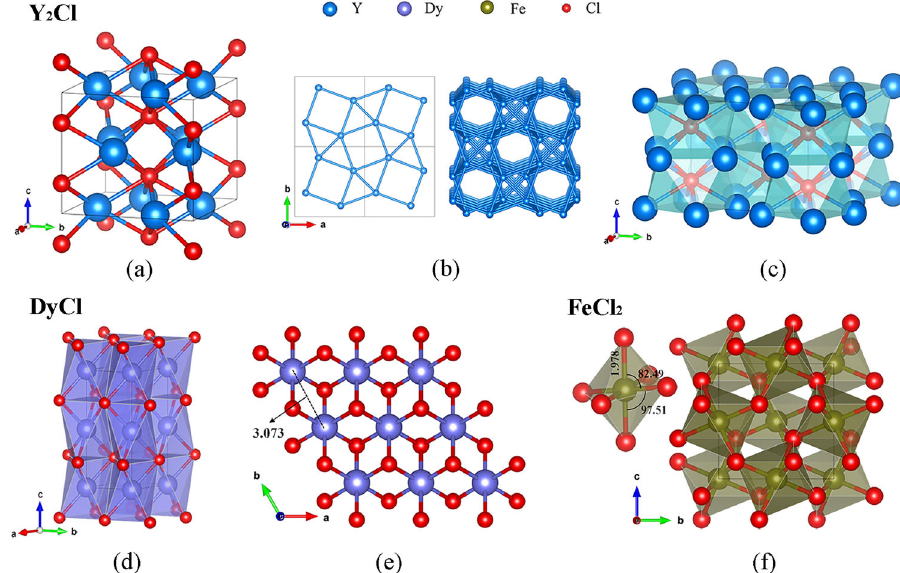
Fig. 2 Crystal structures of novel chlorides of Y, Dy, and Fe. a Stick-and-ball model of Y 2 Cl structure at 41(1) GPa; b view of the Y metal framework in Y 2 Cl along the c -direction; c square antiprisms geometry around the Cl center in Y 2 Cl. d Polyhedral model of the crystal structure of DyCl at 40(1) GPa built of YCl 6 octahedra; e view of the structure along the c -direction: Cl atoms form hexagonal close packing ( hcp ) and Y atoms occupy the space in between. f Polyhedral model of FeCl 2 at 160(1) GPa. Y, Dy, Fe, and Cl atoms are shown in blue, purple, tan, and red colors,